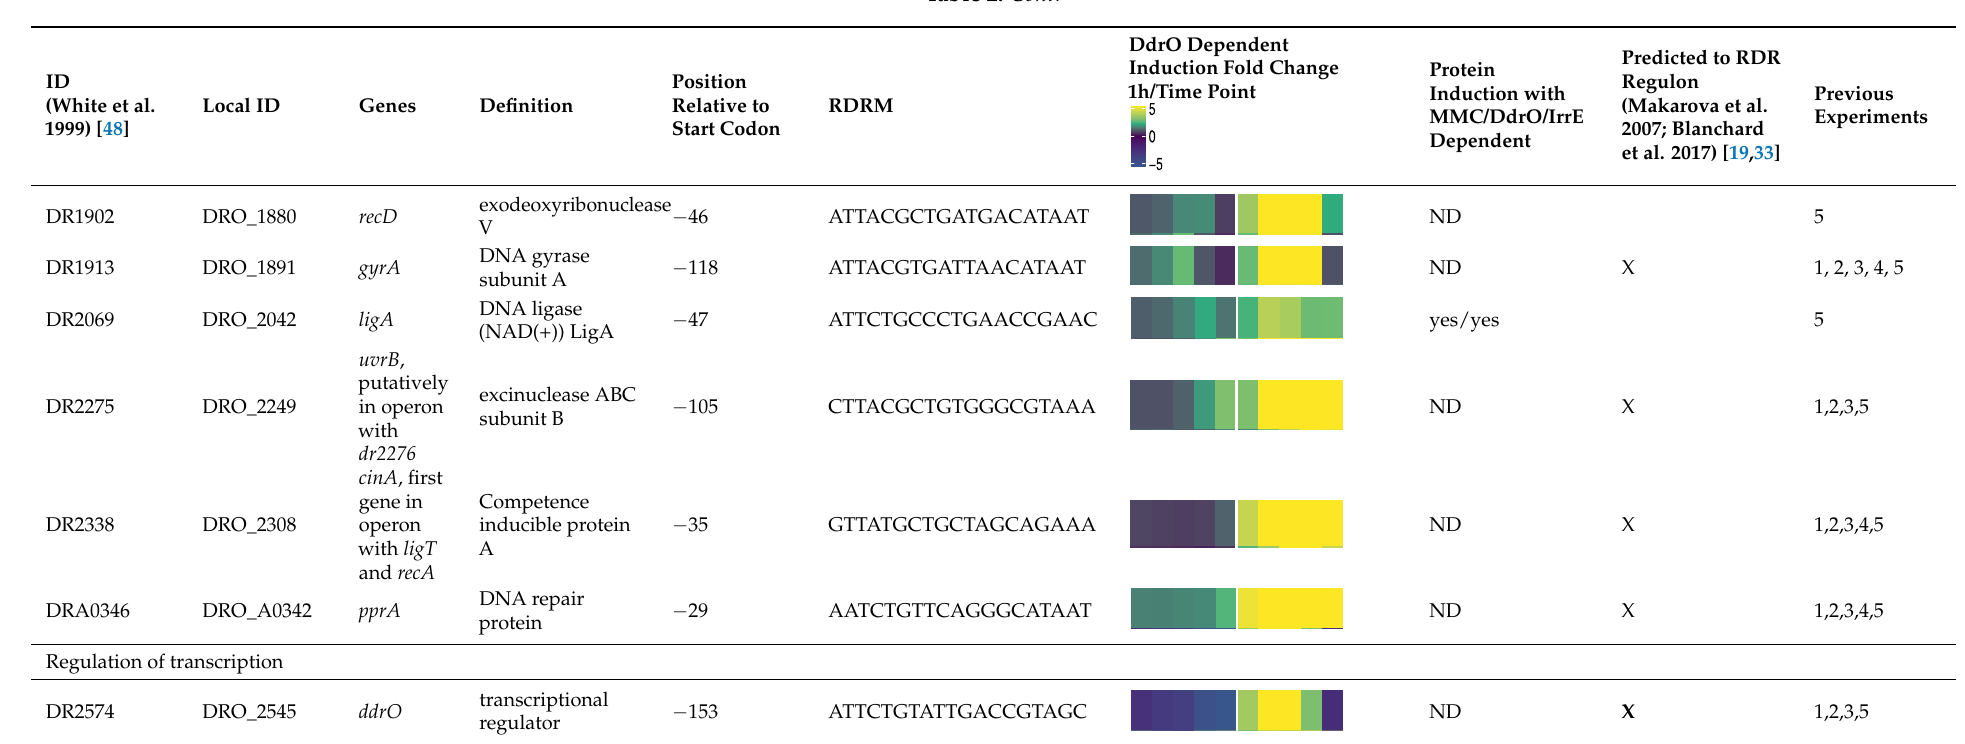
Table 2. List of genes belonging to the DdrO regulon in D. radiodurans matching all criteria (transcriptomic, ChIP-seq, and RDRM). Previous experiments: (1) RDR genes previously predicted by bioinformatic analyses [19,33] (2) by in vitro EMSA assays which analyzed the binding of DdrO to RDRM sequences located in the promoter regions of these genes [26] or shown to be regulated after exposure to radiation by (3) transcriptomic [12], (4) proteomic studies [54], or (5) in a ∆ irrE mutant [24]. Logo of the RDRM consensus performed by MEME from all the RDRM sequences listed in Table 2. ND: Not Table 2. Cont.